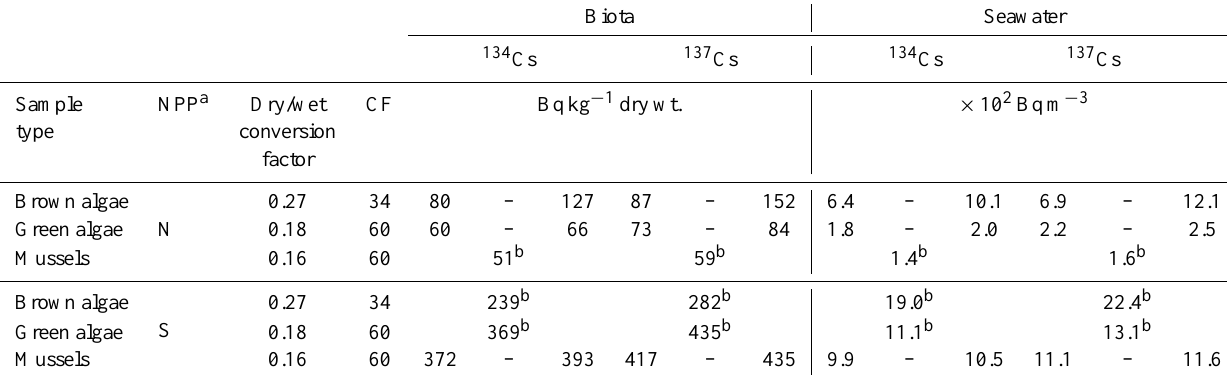
Table 2. Estimates of 134 Cs and 137 Cs concentrations in coastal seawater at the locations north and south of the Fukushima NPP based on concentration factors (CFs; Lkg − 1 ) derived from the literature (IAEA, 2004). Ranges are provided based on the maximum and minimum concentration values for the biota.